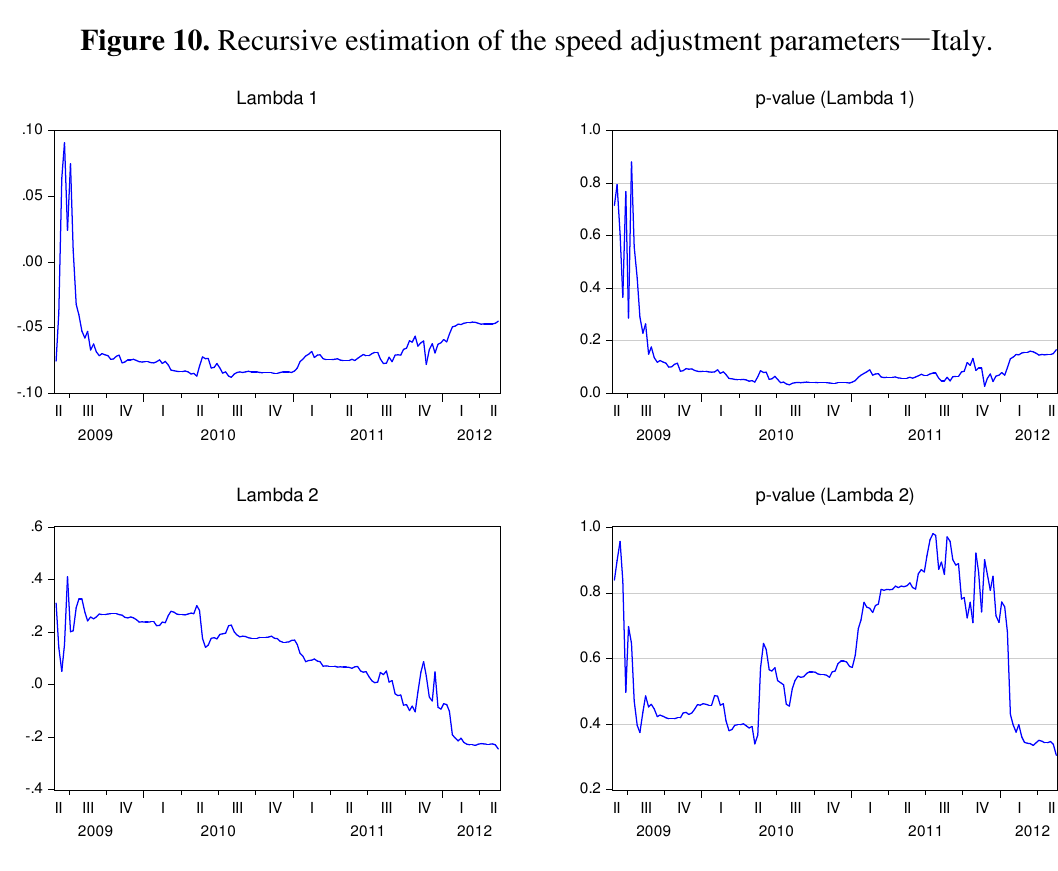
Figure 10. Recursive estimation of the speed adjustment parameters —